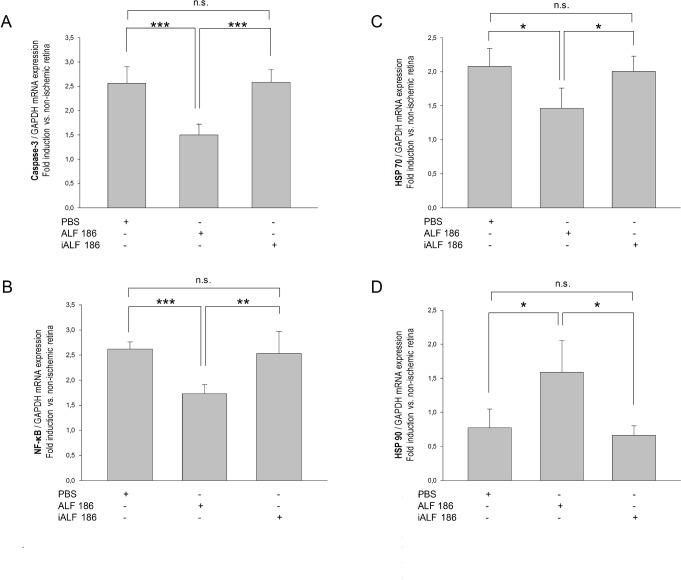
Intravitreal ALF-186 decreased the IRI-induced capsase-3 and NF-κB mRNA expression and affected the heat-shock response differently.(A) Fold induction of caspase-3 mRNA expression after PBS, ALF-186, or iALF injection after IRI compared to GAPDH in relation to the corresponding non-ischemic contralateral retina analyzed by RT-PCR (n = 6; mean±SD; *** = p<0.001; *** = p<0.001). ALF decreased the IRI-induced caspase-3 expression significantly. (B) Fold induction of NF-κB mRNA expression after PBS, ALF-186, or iALF injection+IRI (n = 6; mean±SD; *** = p<0.001; ** = p<0.01). Intravitreal CO suppressed NF-κB mRNA expression after IRI. (C+D) Fold induction of HSP-70 (C) and HSP-90 (D) mRNA expression 24 h after IRI (n = 6; mean±SD; * = p<0.05). While HSP-70 expression was decreased, HSP-90 was induced by ALF.